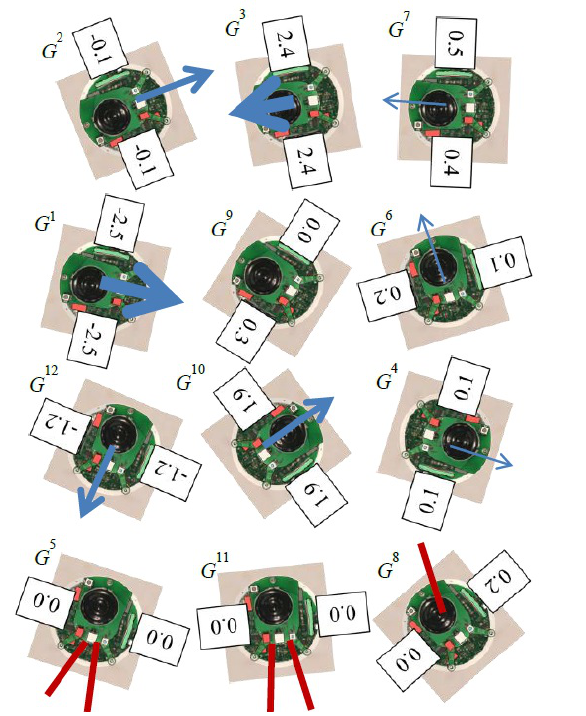
Figure 10: Pictorial representation of maintenance goals generated in the first run of experiment 1. Blue arrows indicate a velocity to maintain: thickness of arrow indicates wheel speed (fatter arrows means faster), image orientation indicates direction. Red lines indi- cate IR sensor to be maintained as